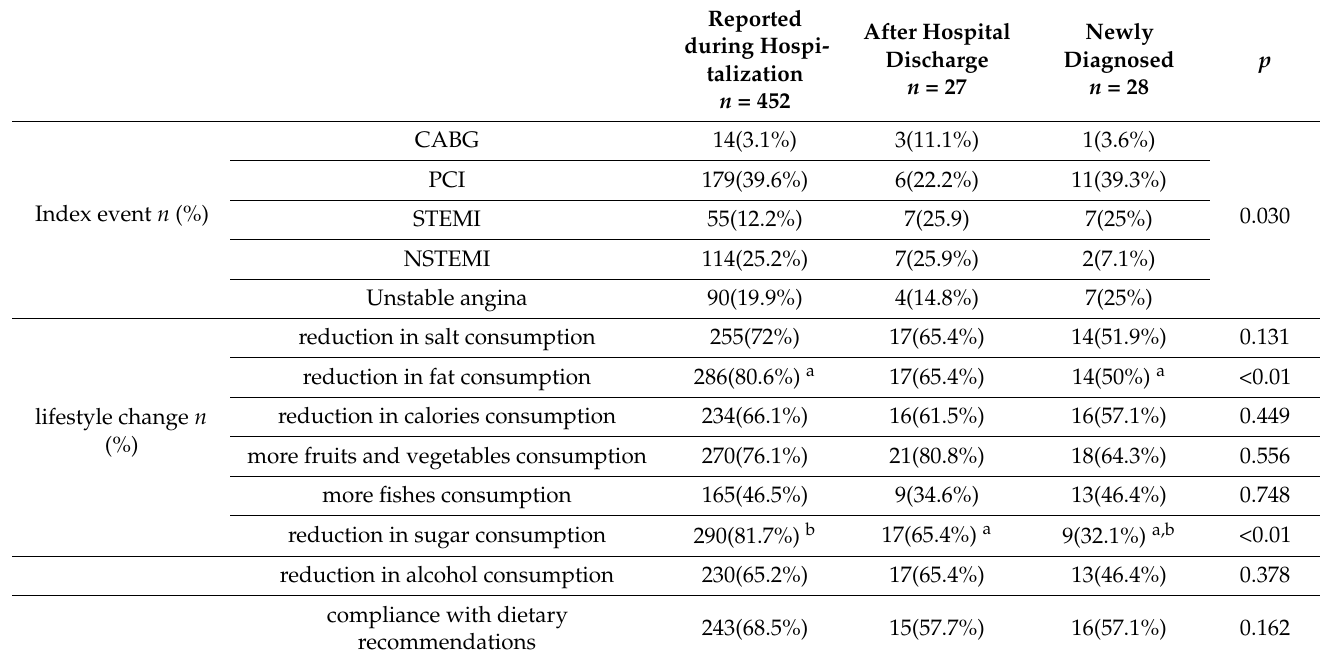
Table 5. Index event and life style changes of all patients with DM.